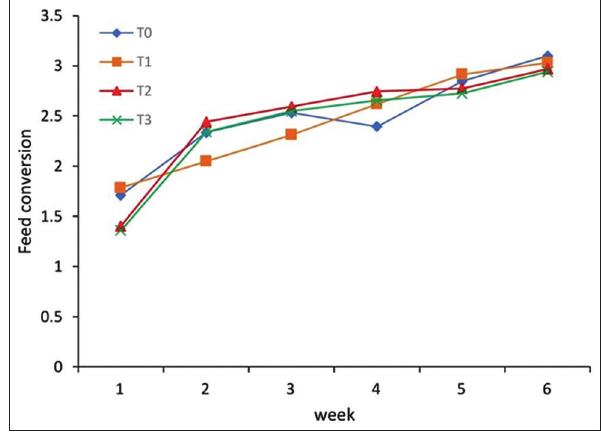
Figure-3: Relationship between diet treatment and feed conversion ratio of native chickens during the starter phase (1-6 Table-3: Average of small intestine morphology size of native chickens at 6 weeks age. Characteristic of intestine